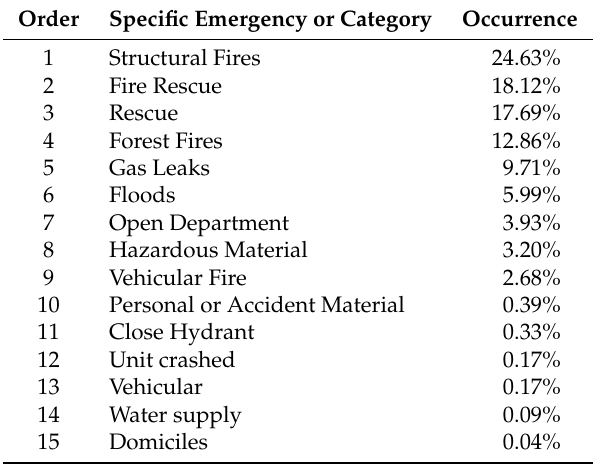
Table 2. Categories or specific emergencies considered in the Data Base (DB) for Fire Brigades and its percentage of occurrence.